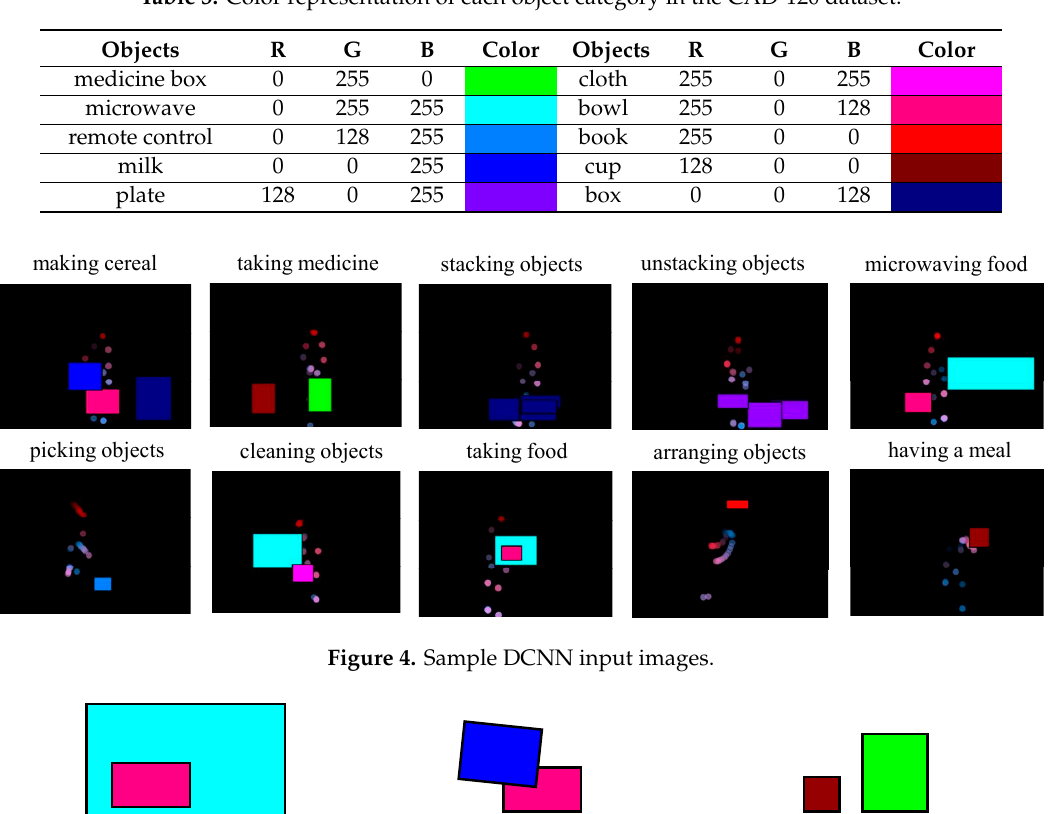
Table 3. Color representation of each object category in the CAD-120 dataset.